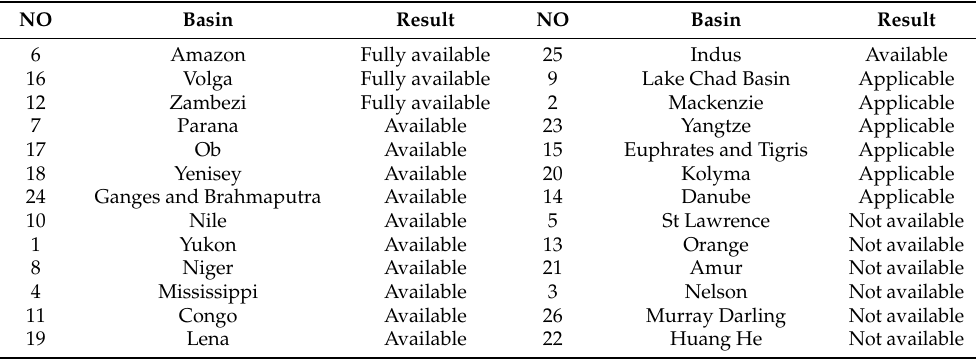
Figure 8. The accuracy classification map of water storage change detection in 26 basins by Swarm. Among them, red represents the area where Swarm is fully available, green represents the area where Swarm is available, cyan represents the area where Swarm can be selectively used, and orange line represents the area where Swarm is not available. Table 18. Statistics on the applicability of Swarm-TWSC in 26